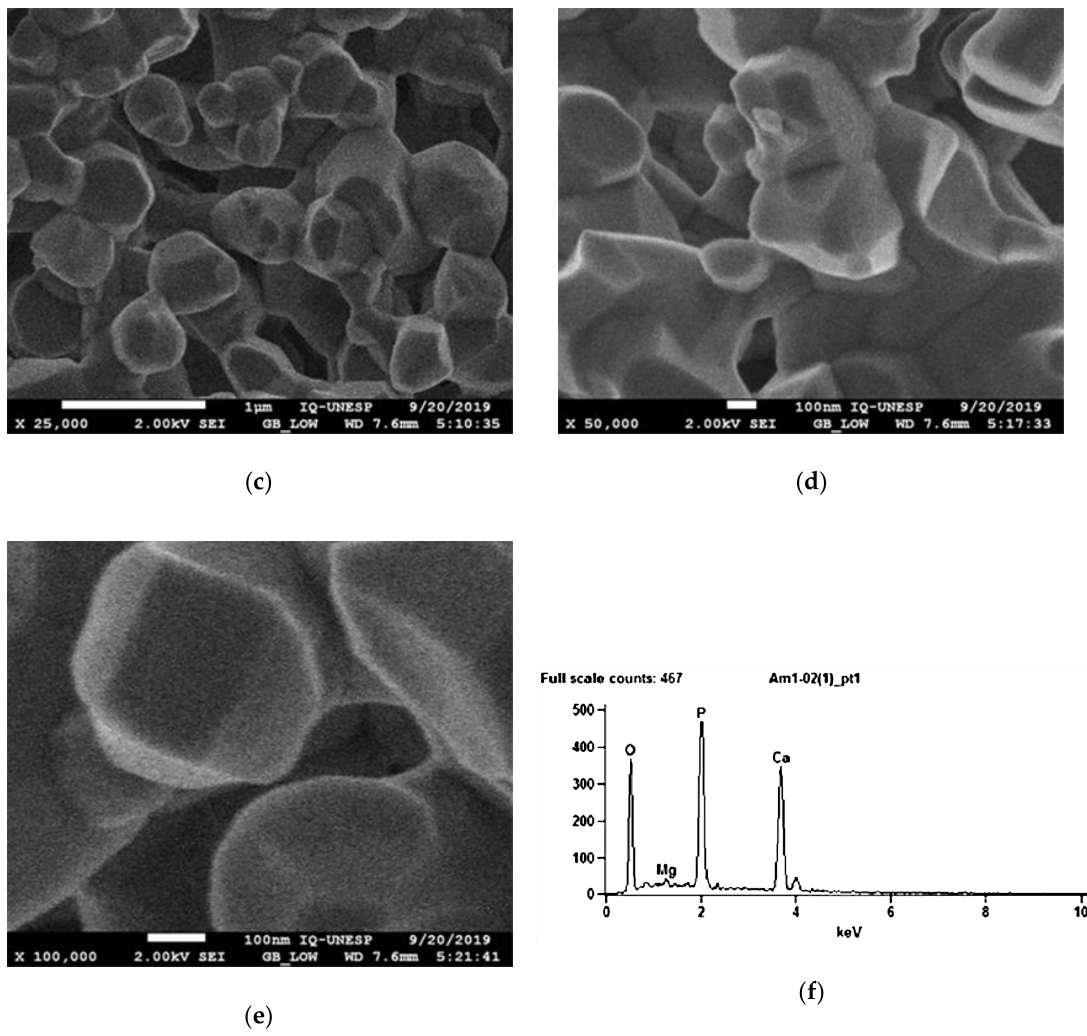
Figure 2. SEM-EDX analysis: ( a – e ) SEM views of the biomaterial surface at ×100, ×5,000, ×25,000, ×50,000, and ×100,000 magnifications, respectively. ( f ) EDX spectrometry values obtained before the surgery. The elements found were phosphorus, oxygen, calcium, and magnesium.